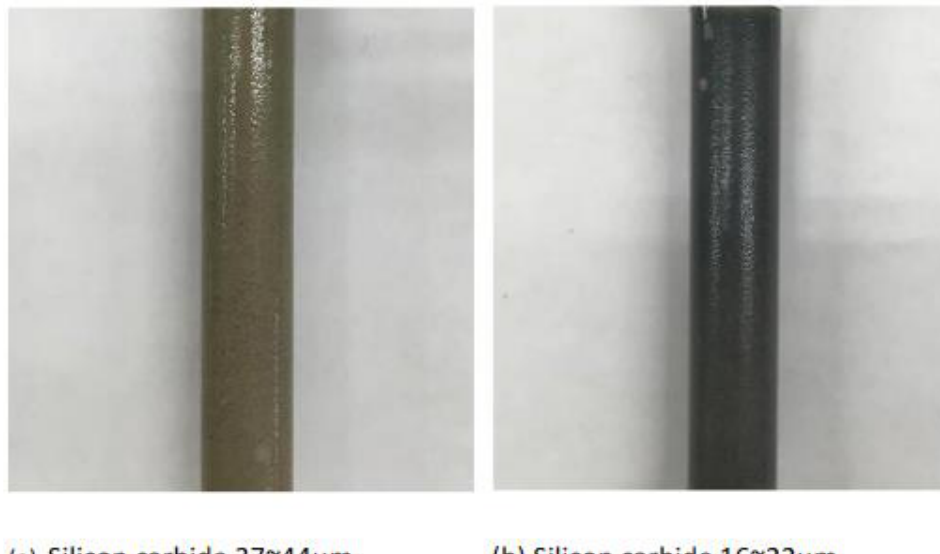
Figure 5. Filtrate flux rate comparison diagram.